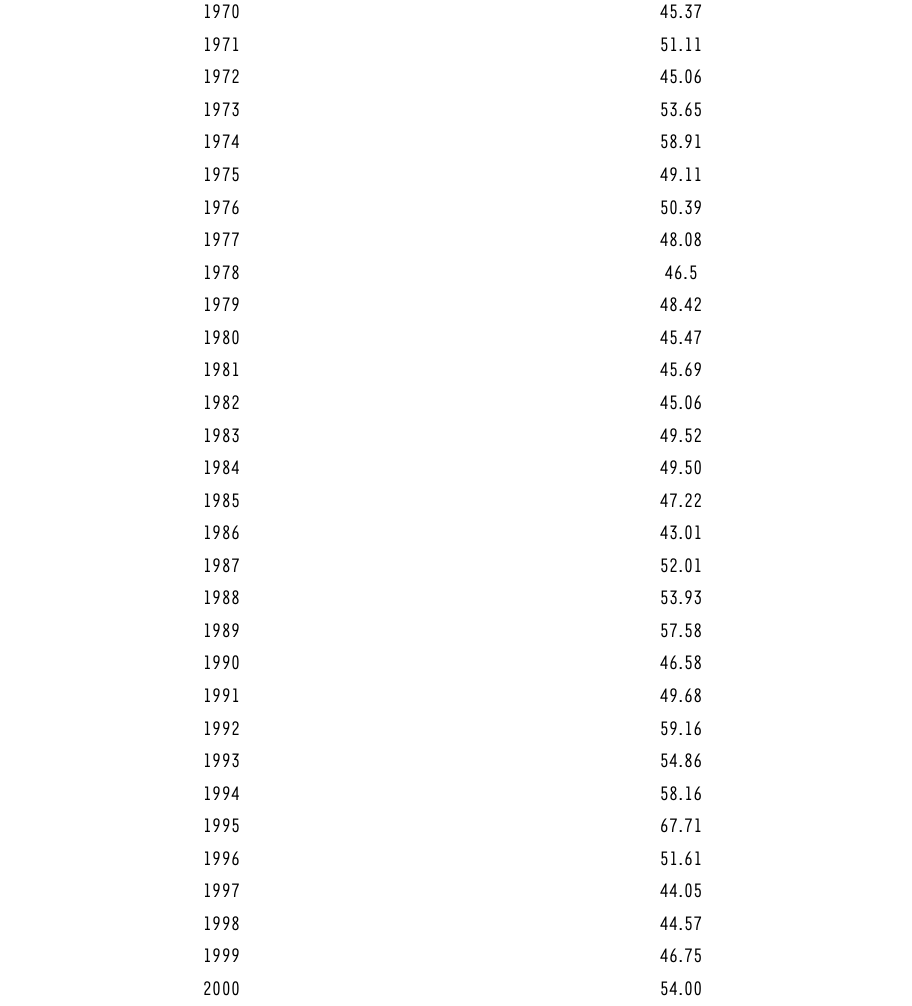
Own estimates based on the Multiple Indicator Multiple Cause (MIMIC)